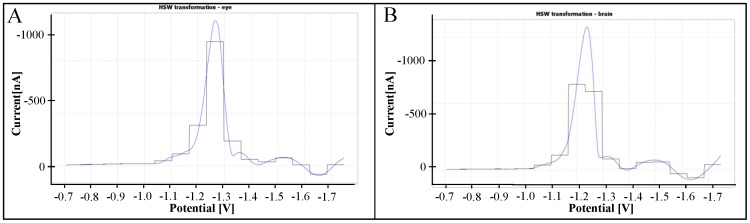
Transformation of DP voltammograms.(A) Haar’s Simple Wavelet transformation – brain. (B) Haar’s Simple Wavelet transformation – eye.